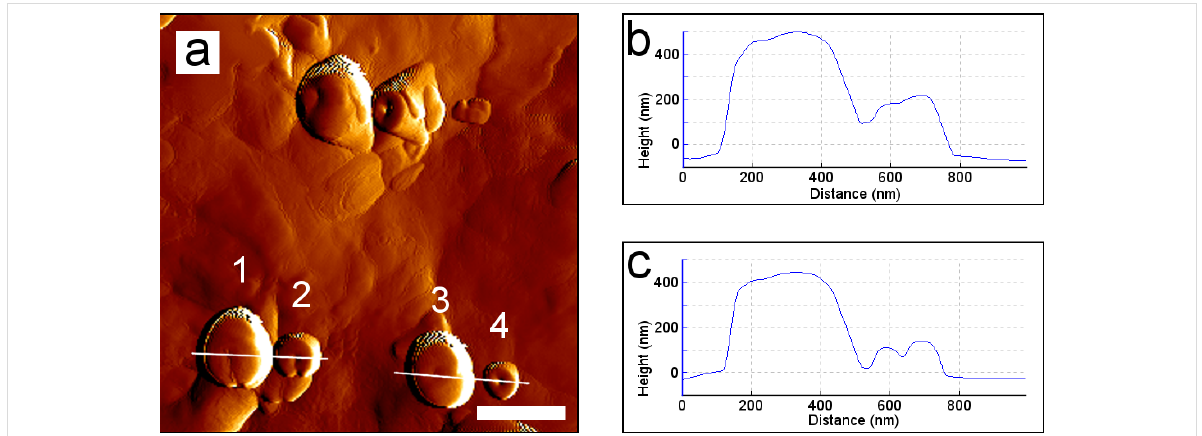
Figure 6: AFM image of recrystallized wax tubules from a wax solution on glass. (a) Top view of vertically growing tubules 22 h and 39 min after appli- cation. (b) Cross section of tubule 1 and 2 and (c) cross sections of tubule 3 and 4 seen in (a). Scale bar: 500 nm.